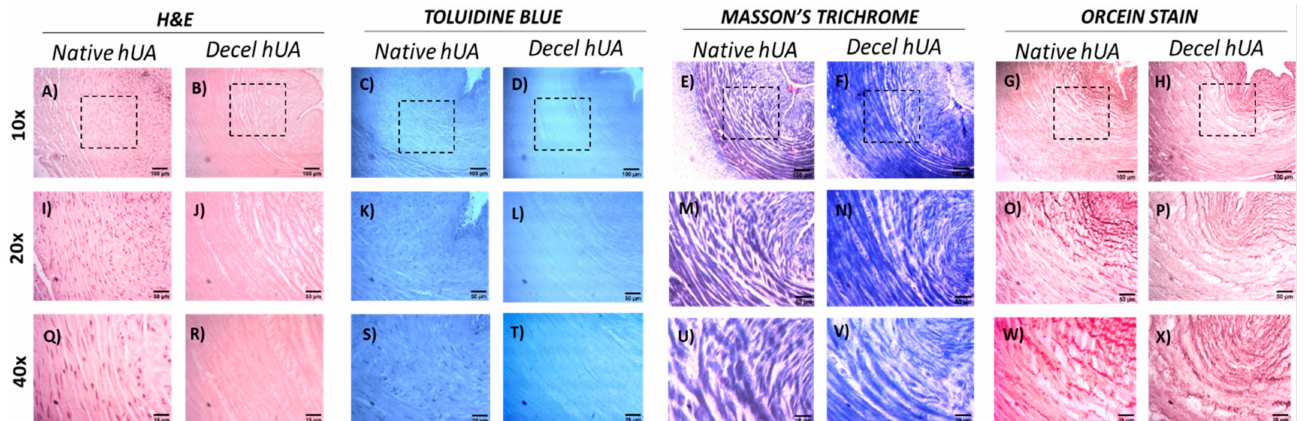
Figure 1. Histological analysis of hUAs (including native and decellularized samples). Native and decellularized hUAs stained with H&E ( A , I , Q and B , J , R ), TB ( C , K , S and D , L , T ), MT ( E , M , U and F , N , V ) and OS ( G , O , W and H , P , X ). The black boxes indicated the magnified field of 20 × and 40 × images. Images were presented with original magnification 10 × , scale bars 100 µ m, 20 × , scale bars 50 µ m and 40 × , scale bars 25 µ m. H&E: Hematoxylin and Eosin, TB: Toluidine Blue, MT: Masson’s Trichrome, OS: Orcein